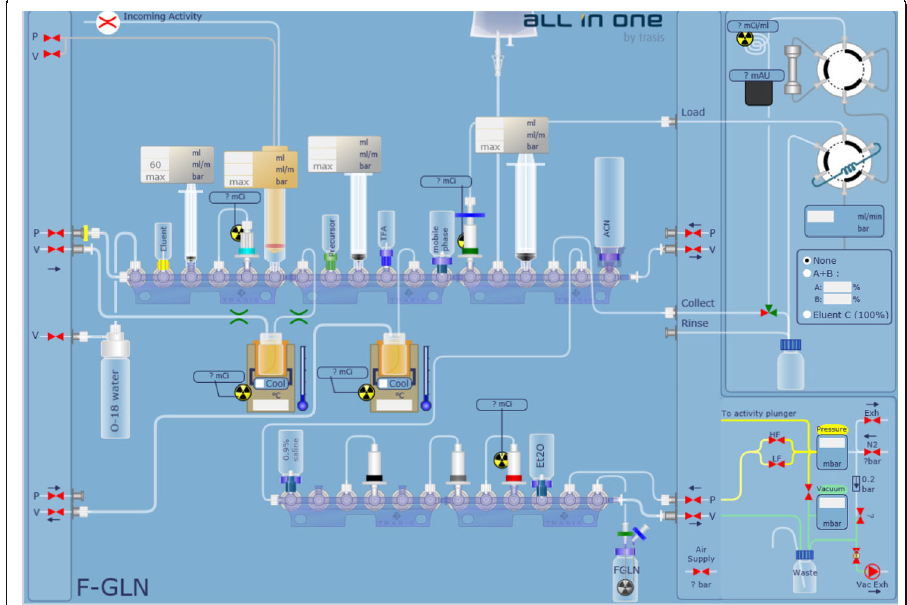
Fig. 4 AllinOne user software interface for two-vessel reaction ([ 18